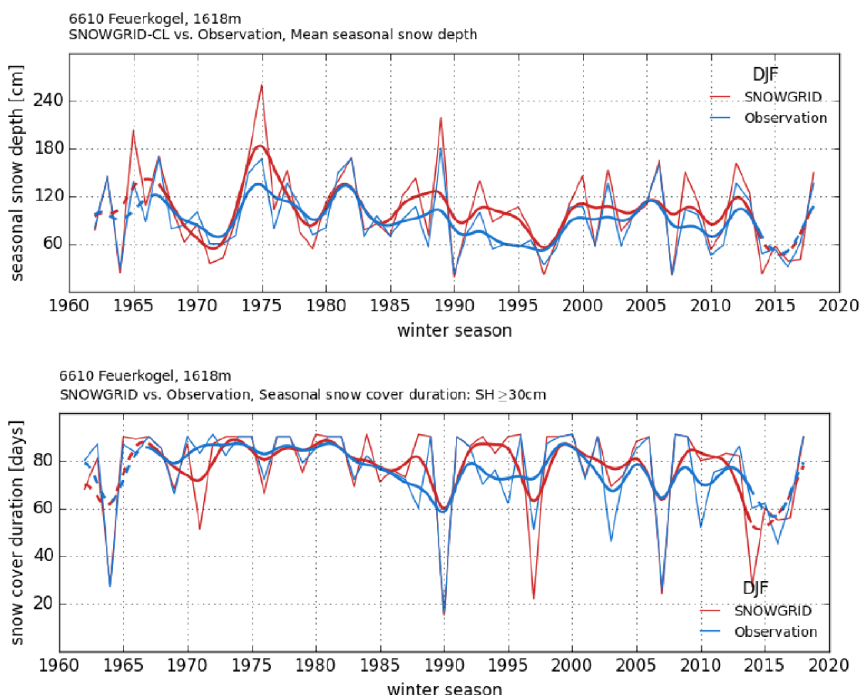
Figure 4. Observed versus modelled seasonal (DJF) mean snow depth HS ( top ) and snow cover duration SCD (HS ≥ 30 cm; bottom ) for the ZAMG (Austrian weather service) climate station Feuerkogel (1618 m a.s.l.). Blue indicates the observation and red the SG-CL simulation. A Gaussian filter with window size of 11 years was applied to smooth the time series (thick lines).